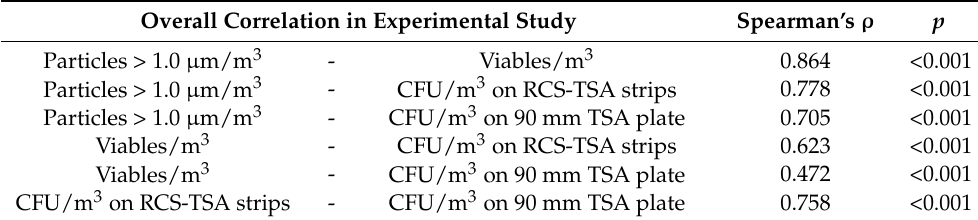
Table 4. Correlation of particles/viables vs. CFUs.